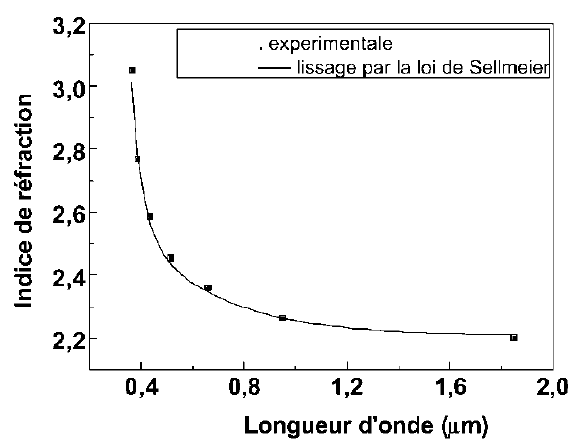
FIGURE 4b Indice de re´fraction calcule´ sur chaque frange d’interfe´rence et lissage des points expe´rimentaux par la loi de